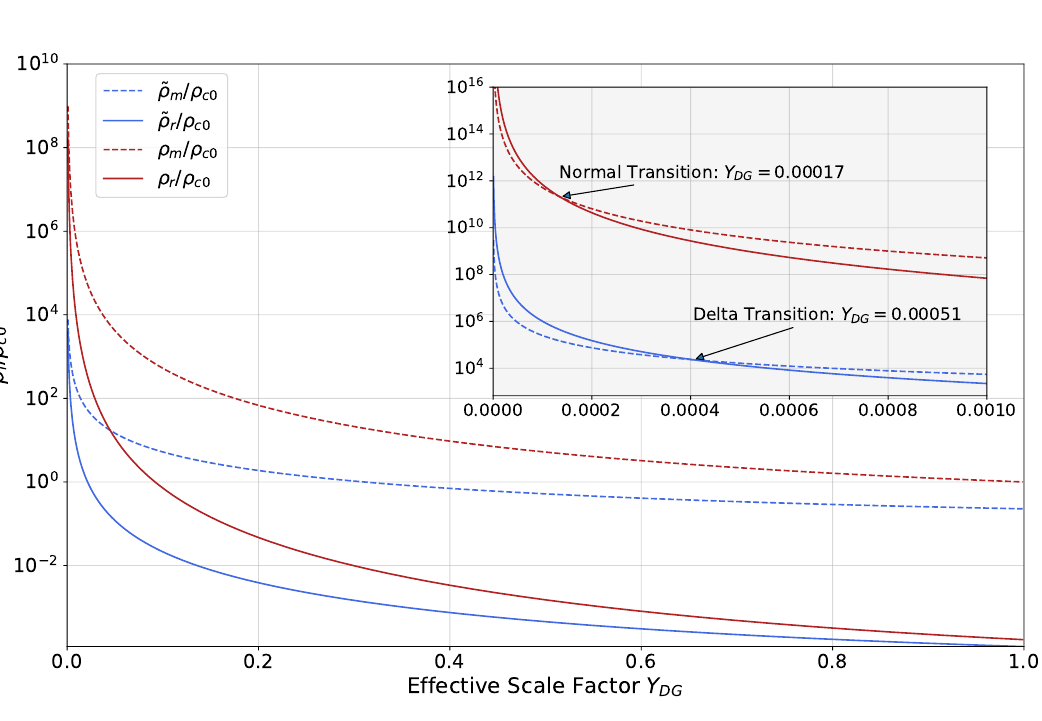
Figure 11. Temporal evolution of density components for Delta Gravity. The vertical axis is normalized by critical density at current time ρ c 0 . On the top right corner, there is a zoom in very close to Y DG = 0 showing the transition between Delta Matter and Delta Radiation (Delta components), and the transition between matter and radiation (common components). In general, the Common Density is higher than the Delta